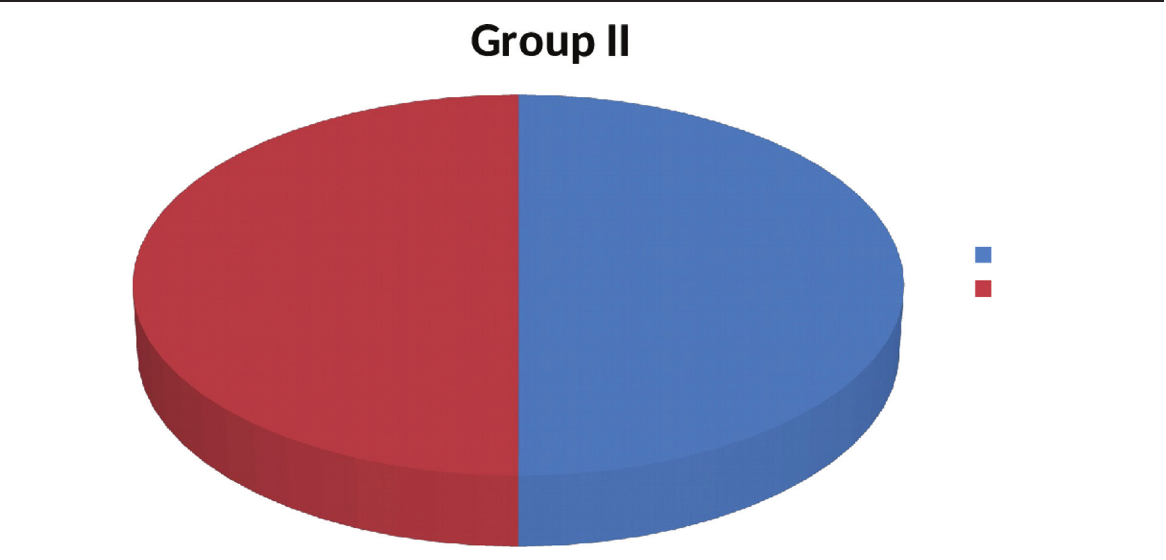
Risk stratification according to GOLD classification [7].